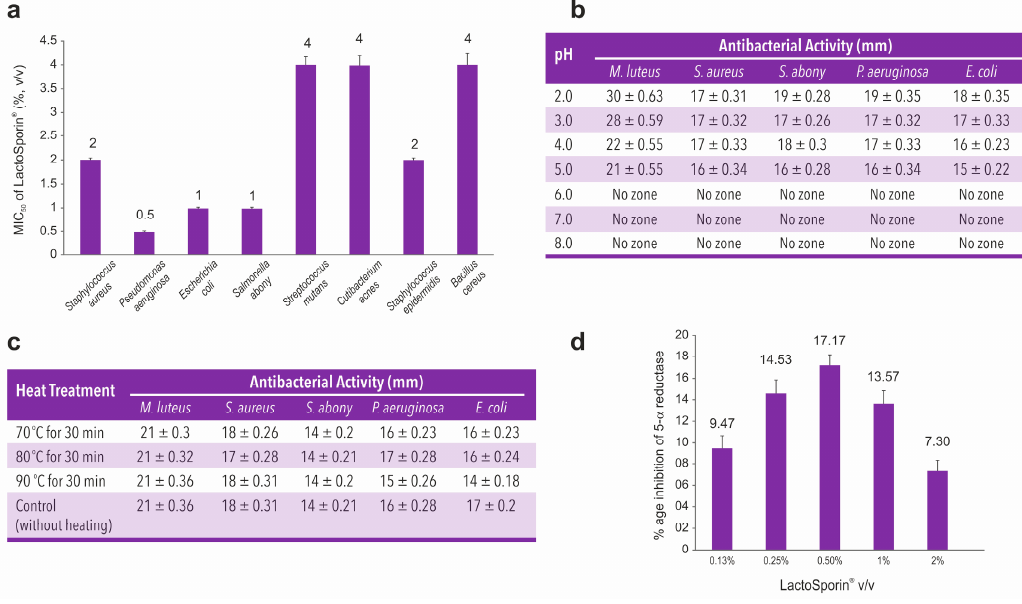
Figure 1. In-vitro studies of LactoSporin. ( a ) Minimum inhibitory concentration (MIC 50 ) of LactoSporin to inhibit the bacterial species, i.e., Pseudomonas aeruginosa, Escherichia coli , Salmonella abony , Streptococcus mutans , Cutibacterium acnes , Staphylococcus aureus , Staphylococcus epidermidis and Bacillus cereus. ( b ) Table showing the e ff ects of pH on the antibacterial activity of LactoSporin. ( c ) Table showing the e ff ects of temperature on the antibacterial activity of LactoSporin. ( d ) 5-alpha reductase inhibitory activity of LactoSporin. Values are expressed as mean ±